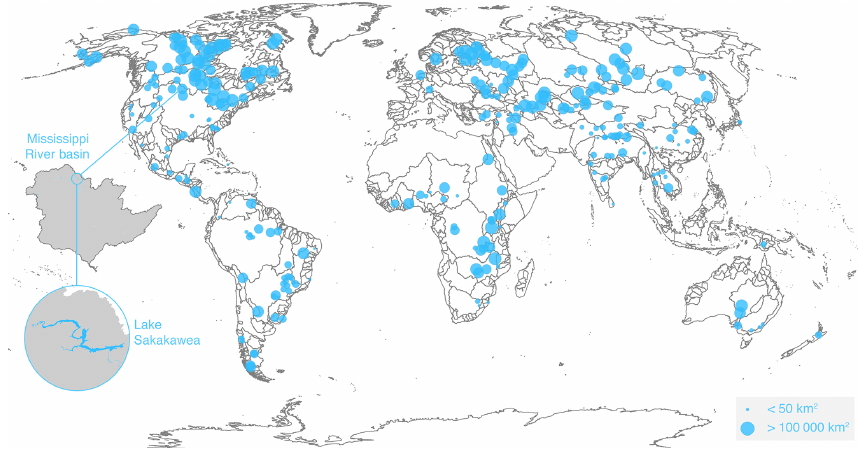
Figure 1. Location of the global targets (blue bubbles, by average lake size) and Lake Sakakawea (approximate coordinates: 47.50 ◦ N, 101.41 ◦ W) within the Mississippi River basin